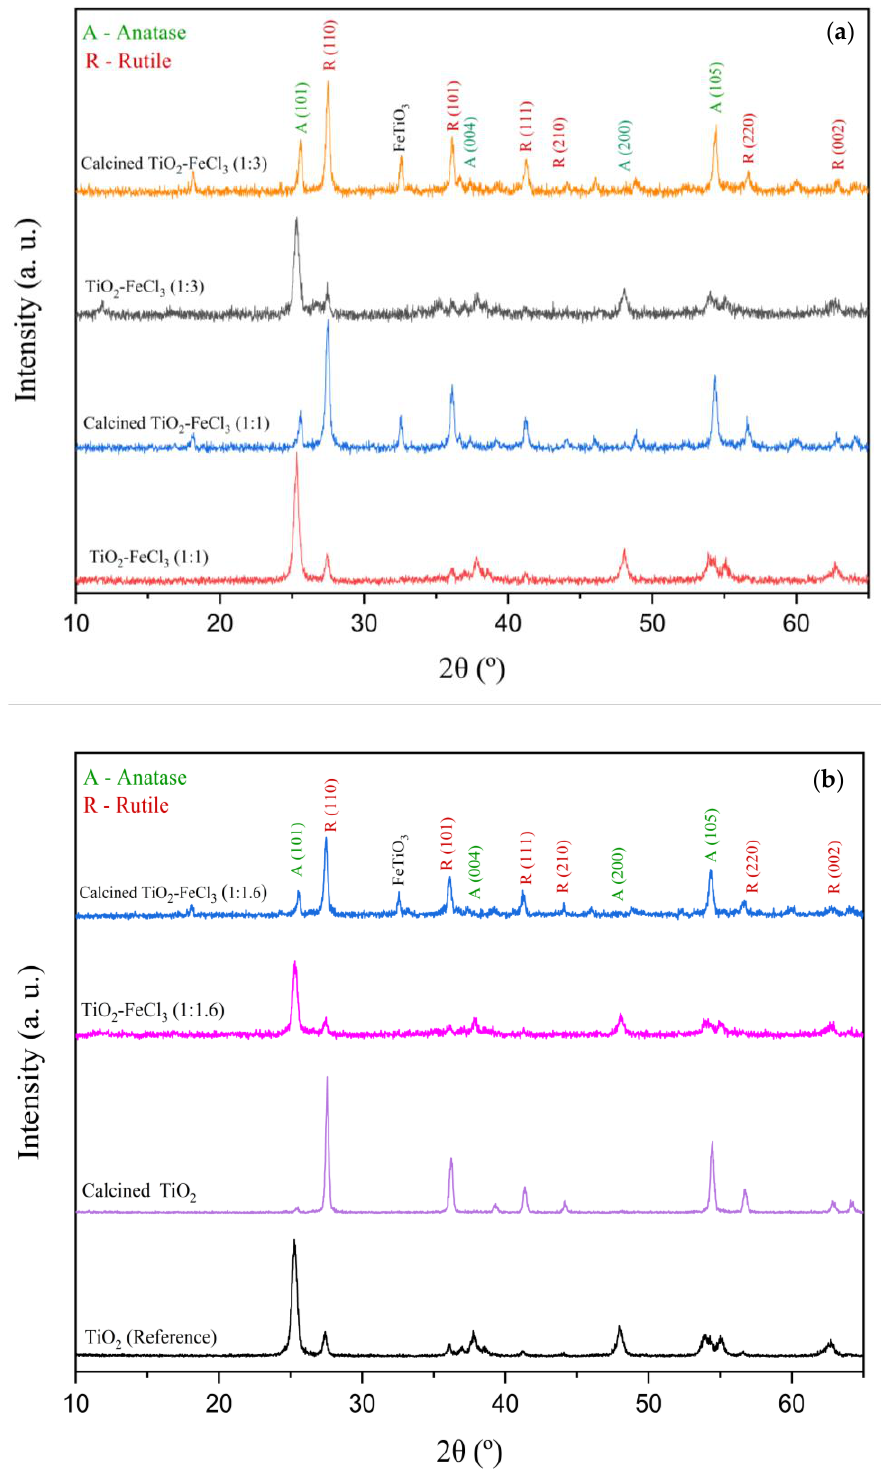
Figure 2. X-ray diffraction patterns of doped and undoped TiO 2 before and after calcination: ( a ) 1:3 and 1:1 and ( b ) 1:1.6 and reference.